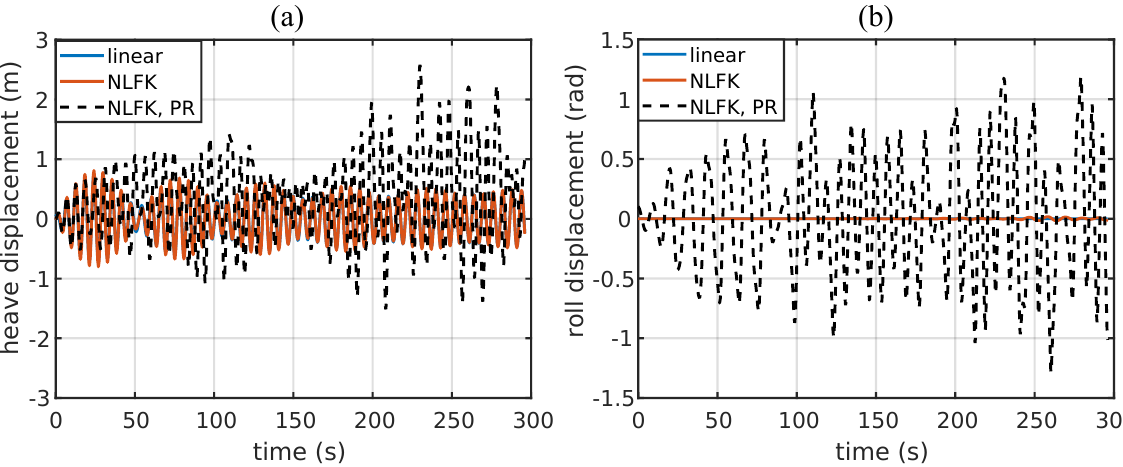
Fig. 6. The effect of initial conditions on the occurrence of parametric resonance, illustrated by the heave and roll displacements in (a) and (b), respectively. In this figure, the PTO and viscous forces are not considered.